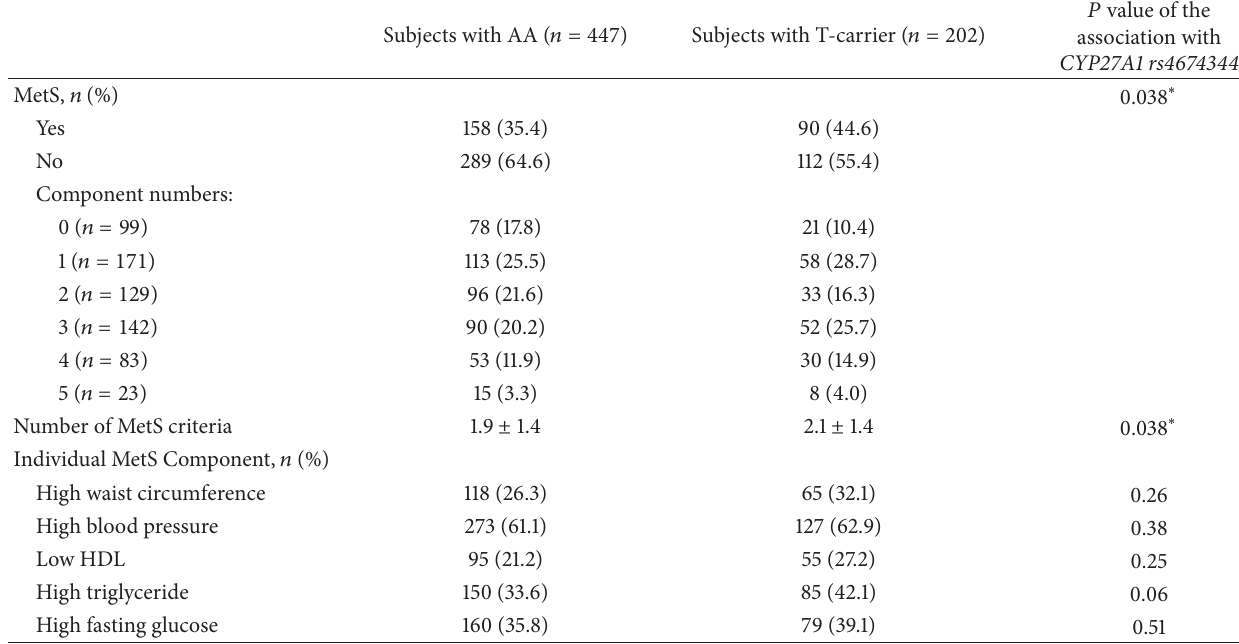
Table 2: Means ± standard deviations or numbers (%) of the MetS parameters in the patients with the CYP27A1 rs4674344